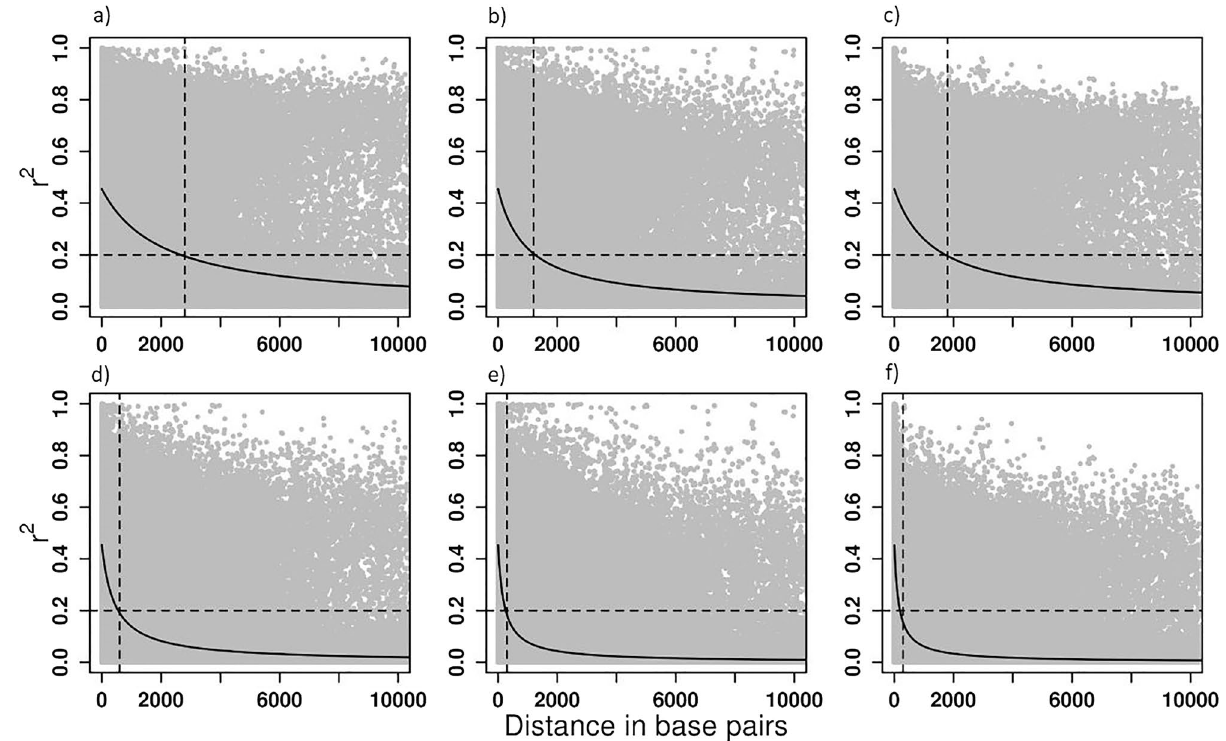
Figure 1. Linkage disequilibrium decay in: ( a ) POP1GF population; ( b ) POP1HD population; ( c ) POP2GF population and linkage disequilibrium decay corrected for bias due to familial relatedness in: ( d ) POP1GF population; ( e ) POP1HD population; ( f ) POP2GF